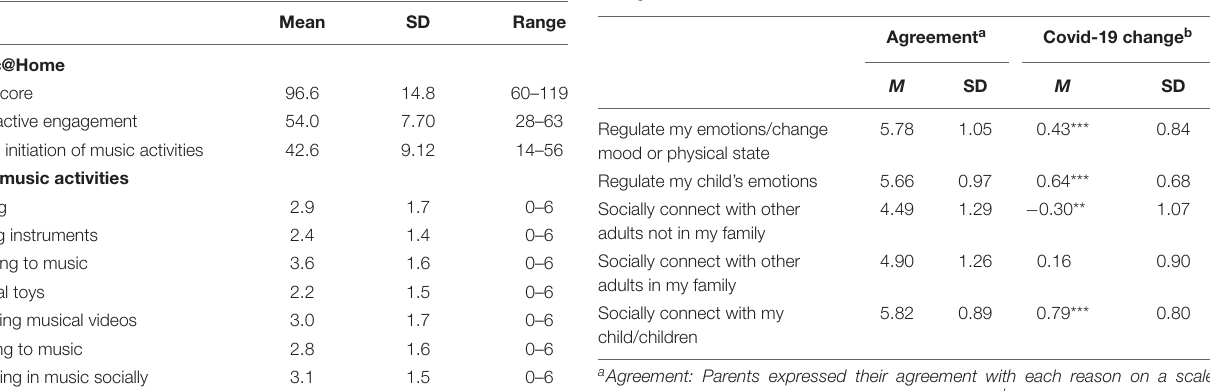
TABLE 2 | Parent-child music engagement and child music activities.